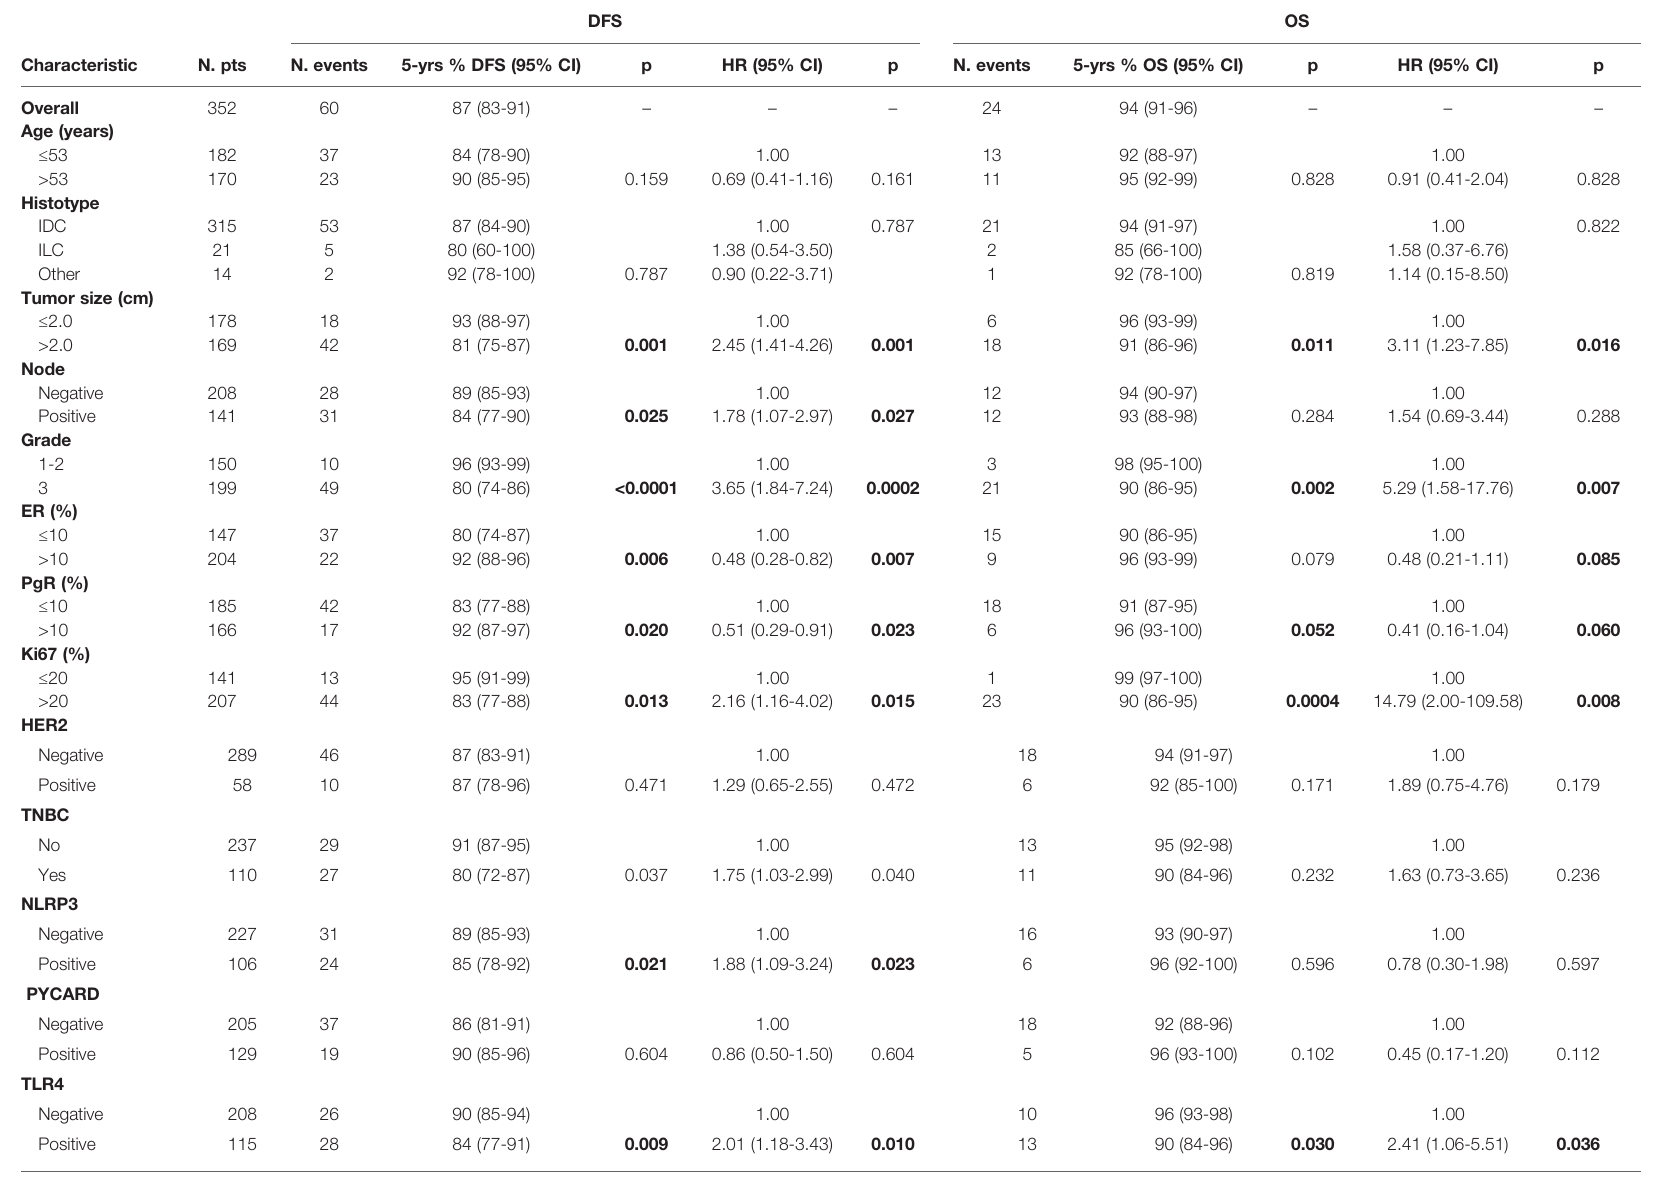
TABLE 4 | Univariate analysis of DFS (disease-free survival) and OS (overall survival).